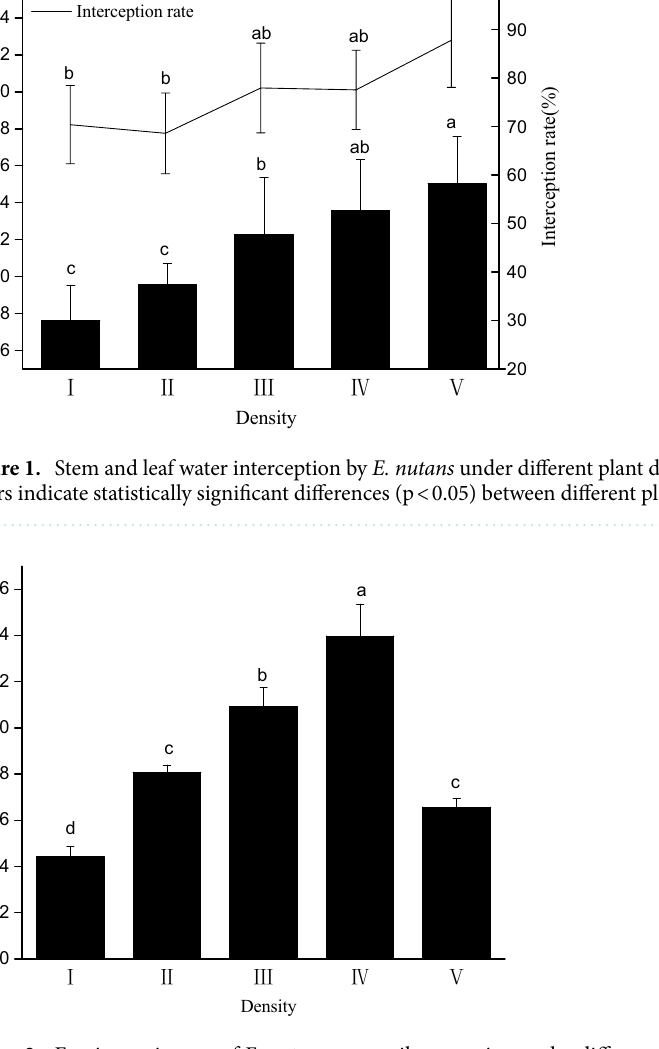
Figure 2. Erosion resistance of E. nutans root–soil composites under different plant density treatments. Lowercase letters indicate statistically significant differences (p < 0.05) between different plant density